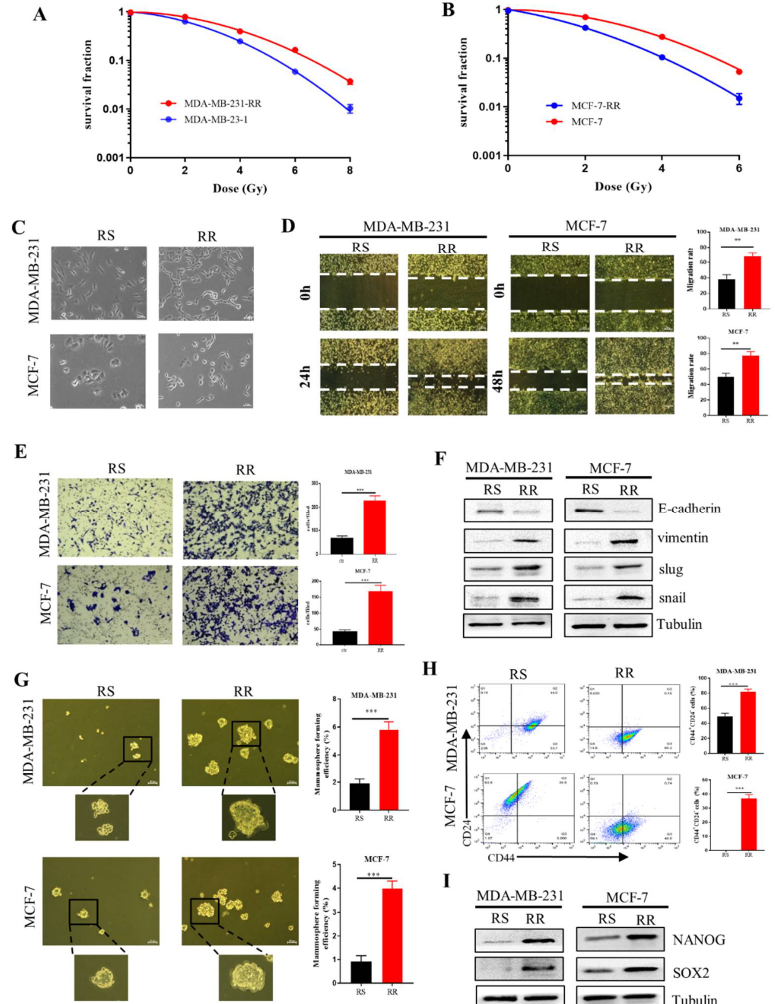
Figure 4. The enhanced EMT and stem-like traits in radioresistant breast cancer cells. ( A , B ) Clono- genic survivals of radiosensitive MDA-MB-231 and MCF-7 cells and radioresistant MDA-MB-231RR and MCF-7RR cells after irradiation. ( C ) The representative morphologies of radiosensitive (RS) and radioresistant (RR) MDA-MB-231 and MCF-7 cells. Scale bars, 50 µ m. ( D ) Wound healing assays of the migration rates of indicated breast cancer cells. Scale bars, 250 µ m. ( E ) Transwell assays were employed to examine the invasion of indicated breast cancer cells. Scale bars, 100 µ m. ( F ) The protein expression of snail, slug, vimentin and E-cadherin related to the EMT process was detected by Western Blot. ( G ) Mammosphere formation assay was conducted to test the stemness of indicated breast cancer cells. Spheres bigger than 50 µ m were quantified. Scale bars, 100 µ m. ( H ) The percentages of CD44 + CD24 − cells in the indicated breast cancer cells detected by flow cytometry. ( I ) Western blot assay of the expressions of stemness-related markers of NANOG and SOX2 in the indicated breast cancer cells. ** p < 0.01, *** p <